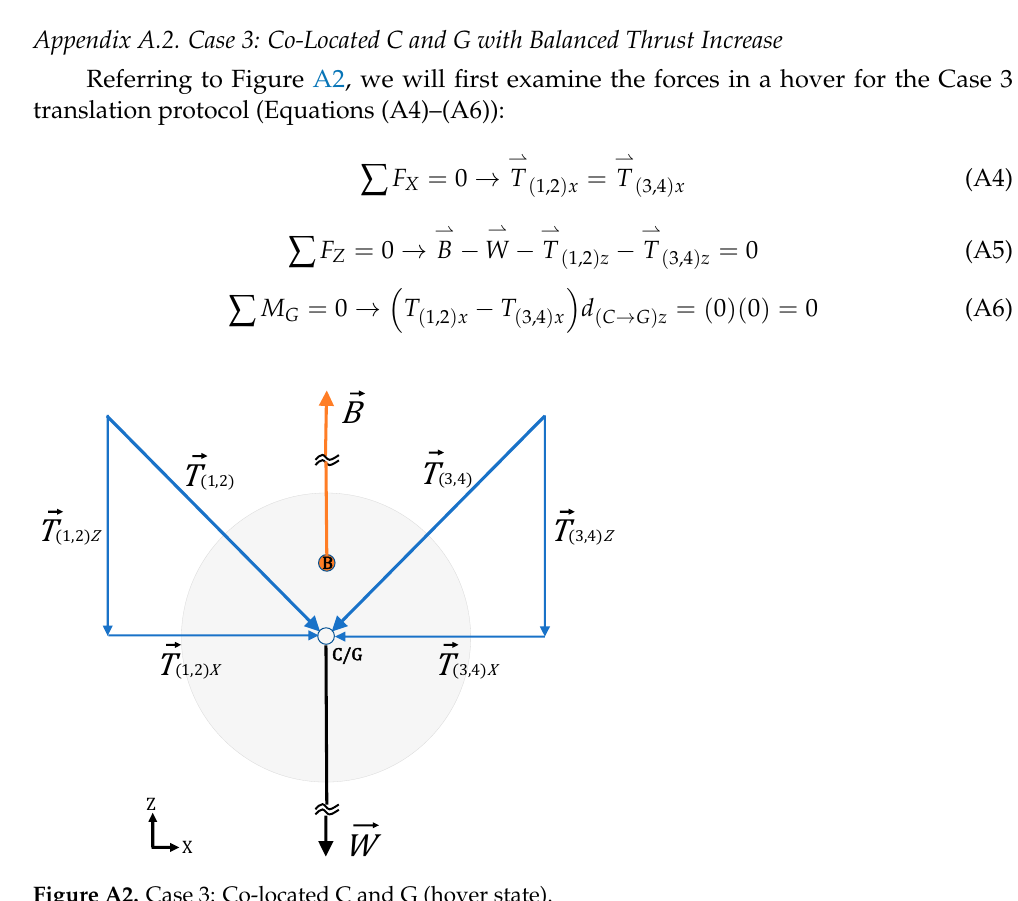
Figure A2. Case 3: Co-located C and G (hover state).